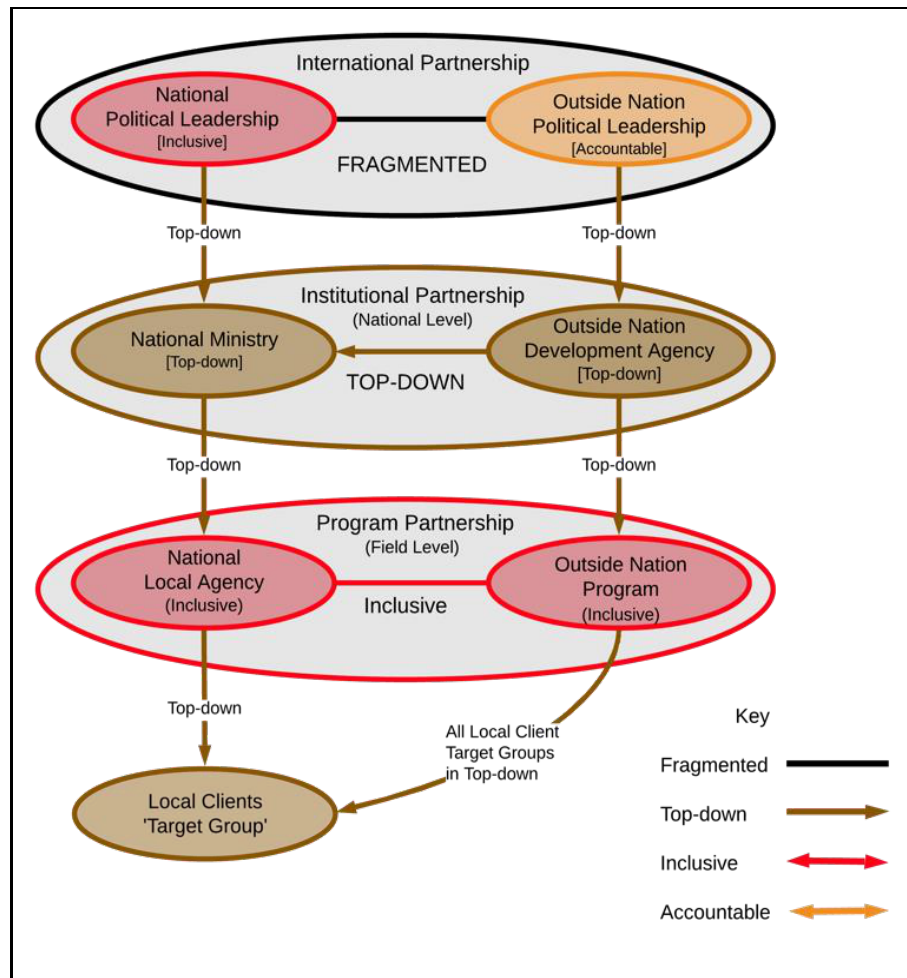
Figure 7. Top-down Partnership Network Map.